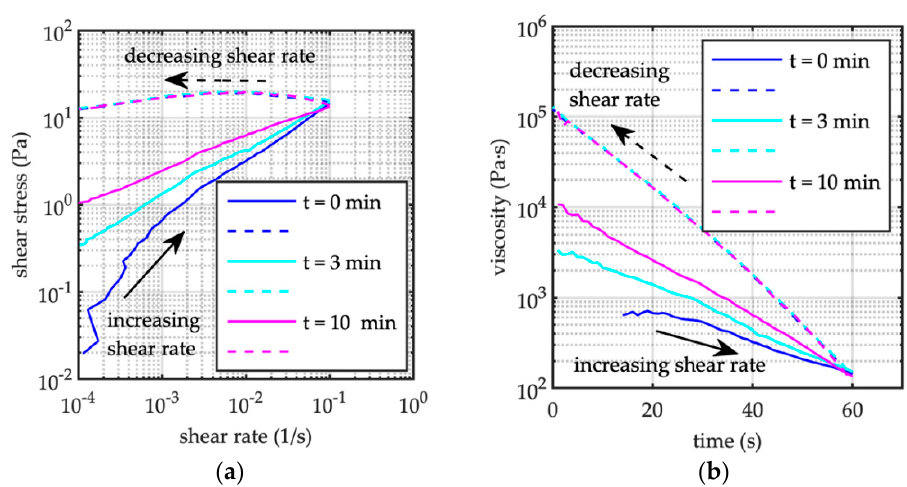
Figure 10. Sediment concentration C = 50%. Low shear rate tests after different resting times. Runs F24 (t = 0 min, reference test), F25 (after resting time of t = 3 min) and F26 (after resting time of t = 10 min). ( a ) Flow curves. ( b ) Apparent viscosity. — increasing shear ramp (time 0–60 s); - - decreasing shear ramp (time 60–0